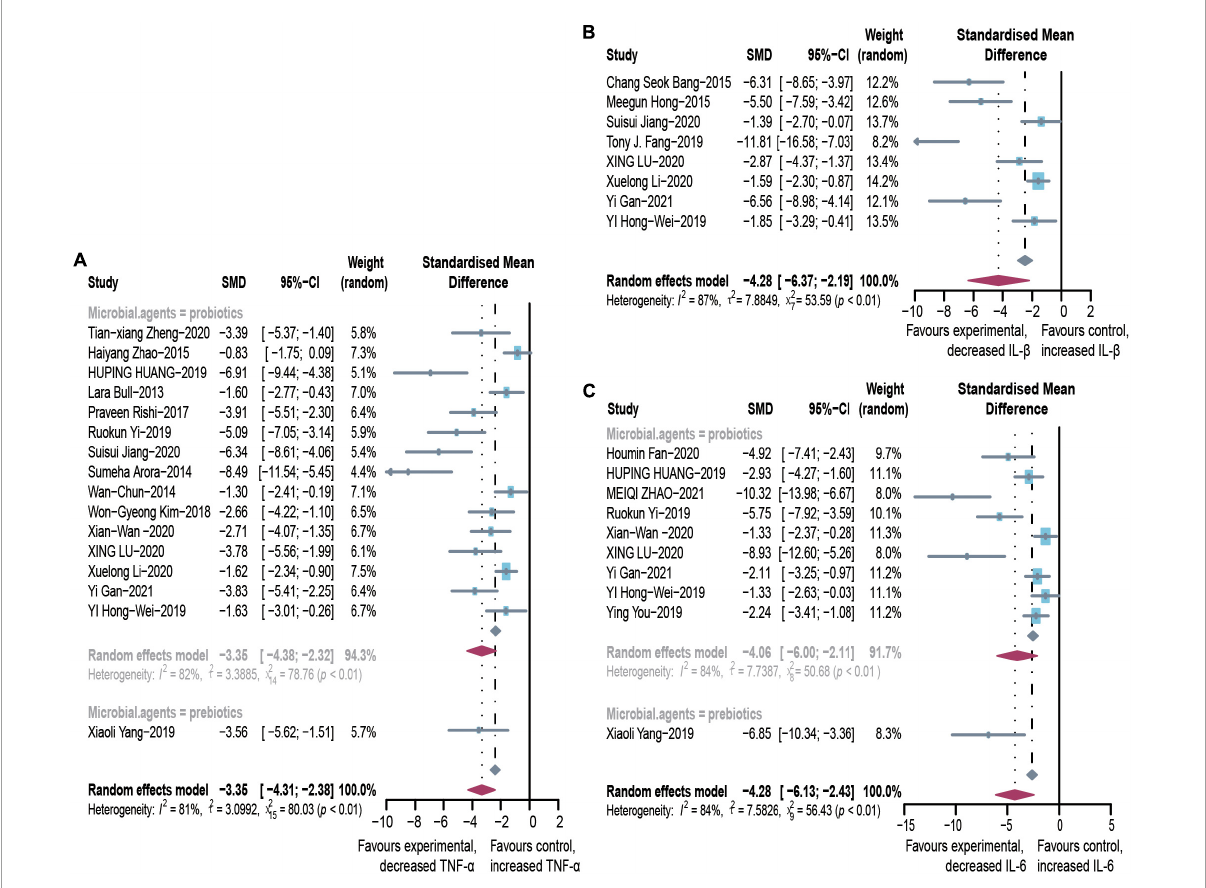
FIGURE5 Effectiveness of microbial agents on inflammatory cytokines. (A) The effect of microbial agents on TNF- α . (B) The effect of microbial agents on IL-1 β . (C) The effect of microbial agents on IL-6. SMD, Standardized mean difference; CI, Confidence